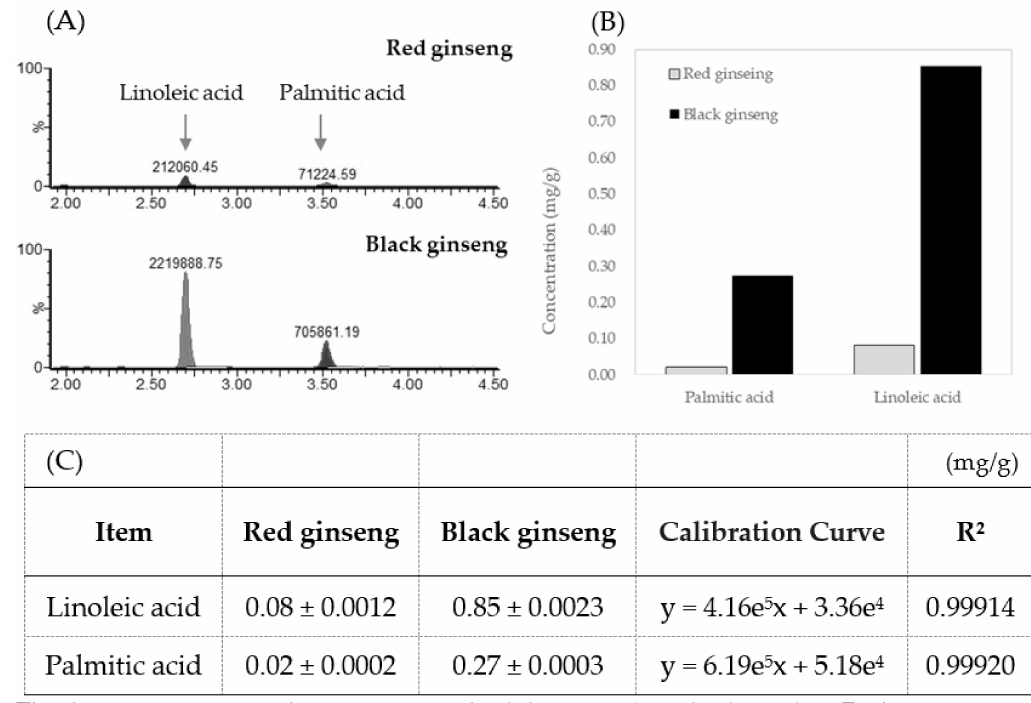
Figure 5. Chromatographic comparison of free fatty acid content in red ginseng and black ginseng ( A ). A ten-fold increase in free fatty acid content was observed in methanol extracts of black ginseng compared to red ginseng ( B ). The results of quantitative analysis of free fatty acids with MRM method using TQD ( C